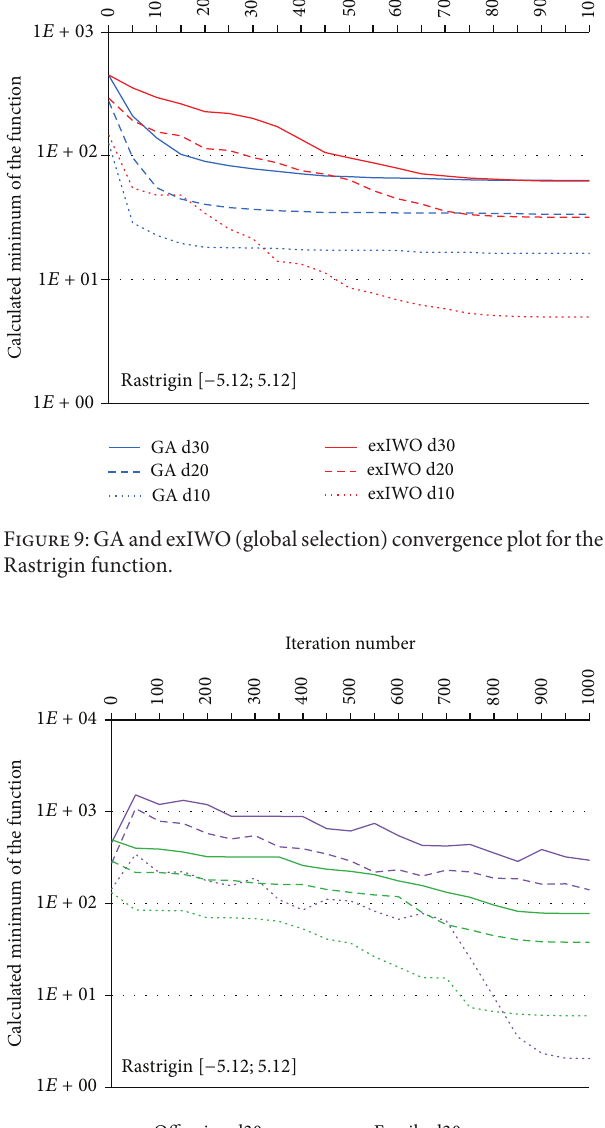
Table 3: The parameters of exIWO and IWO used for minimization of the sphere